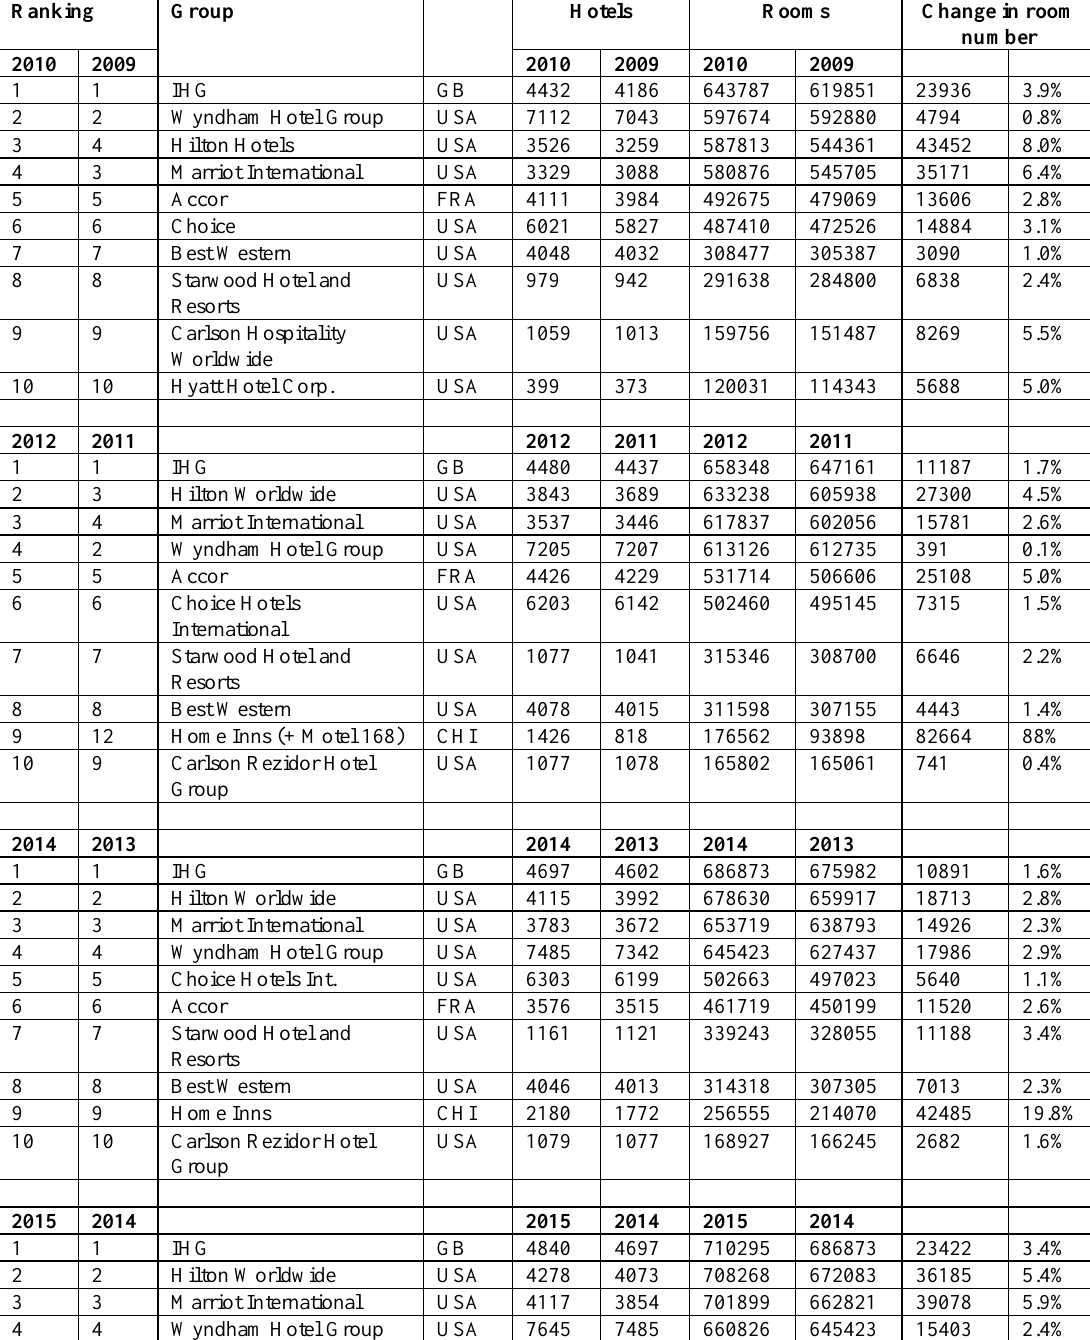
Table 1: Top Ten Hotel Groups in the World